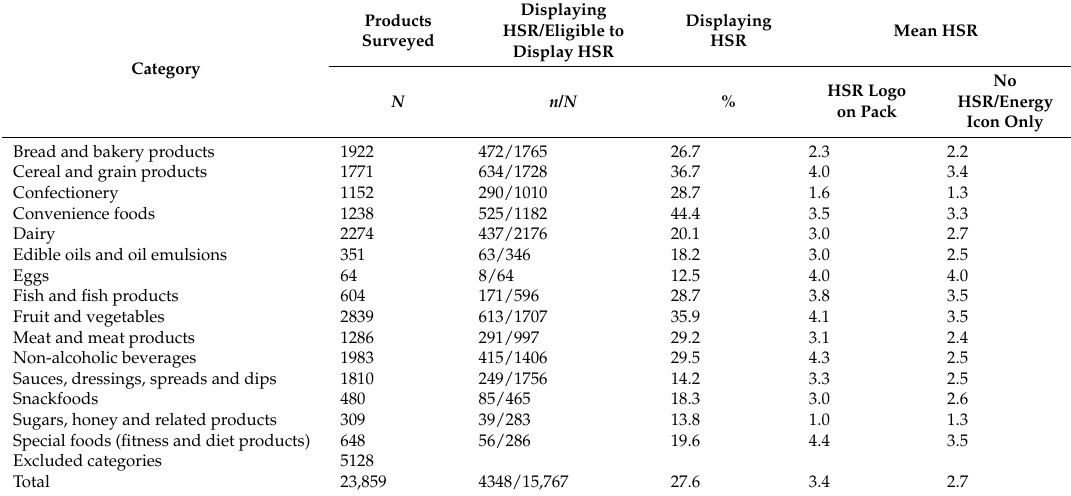
the HSR logo and among products either not displaying the HSR logo or carrying the energy icon only, in the 2017 FoodSwitch Monitoring